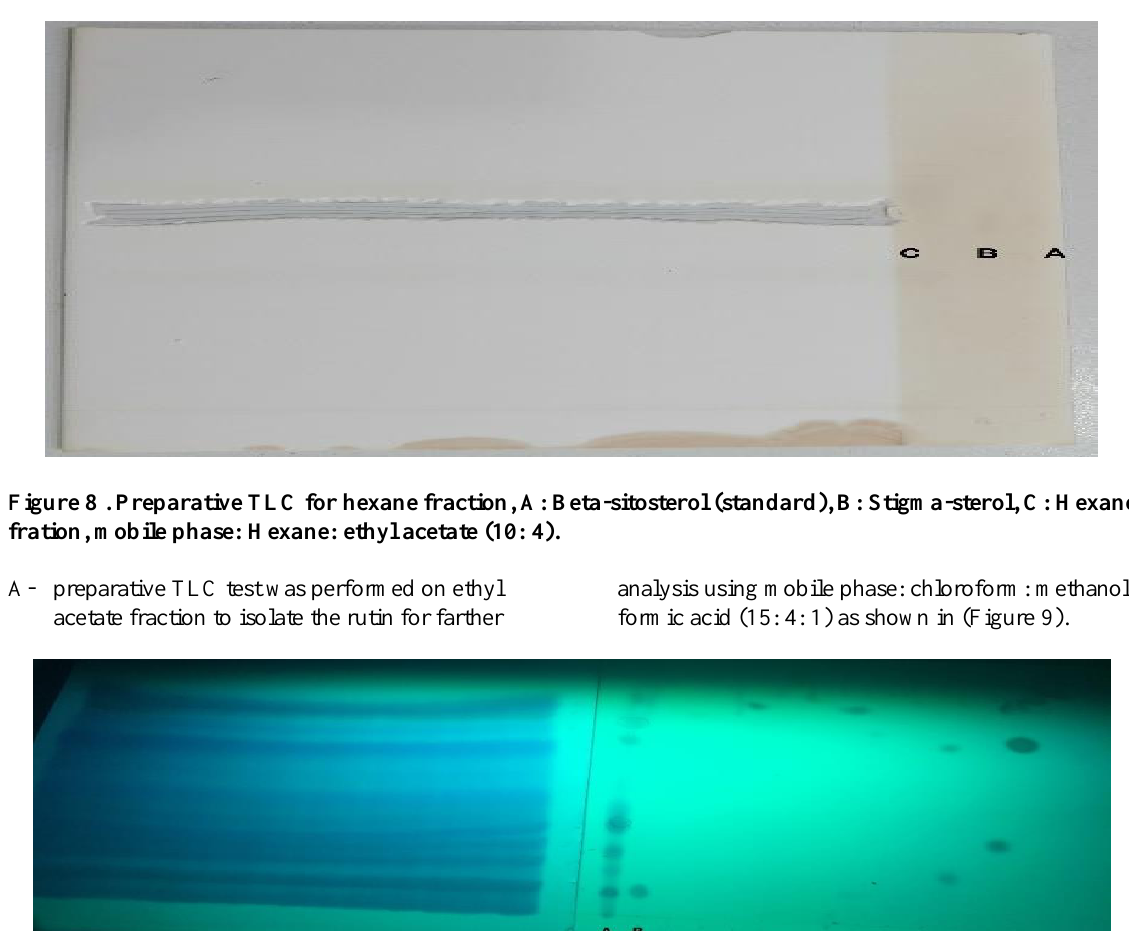
using mobile phase: Hexane: ethyl acetate (10: 4) as shown in (Figure 8).